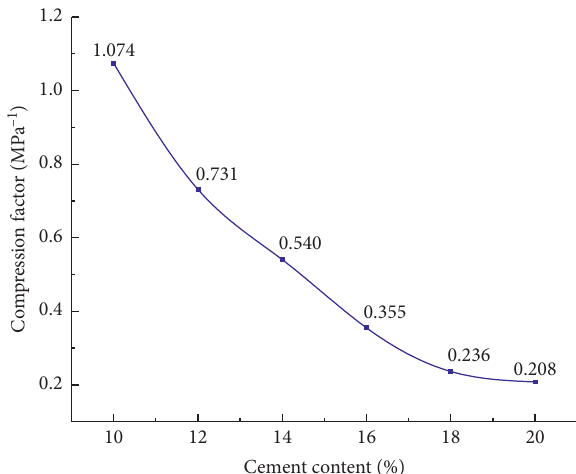
Figure 6: a 1-2 of CCS-28 with different cement content.